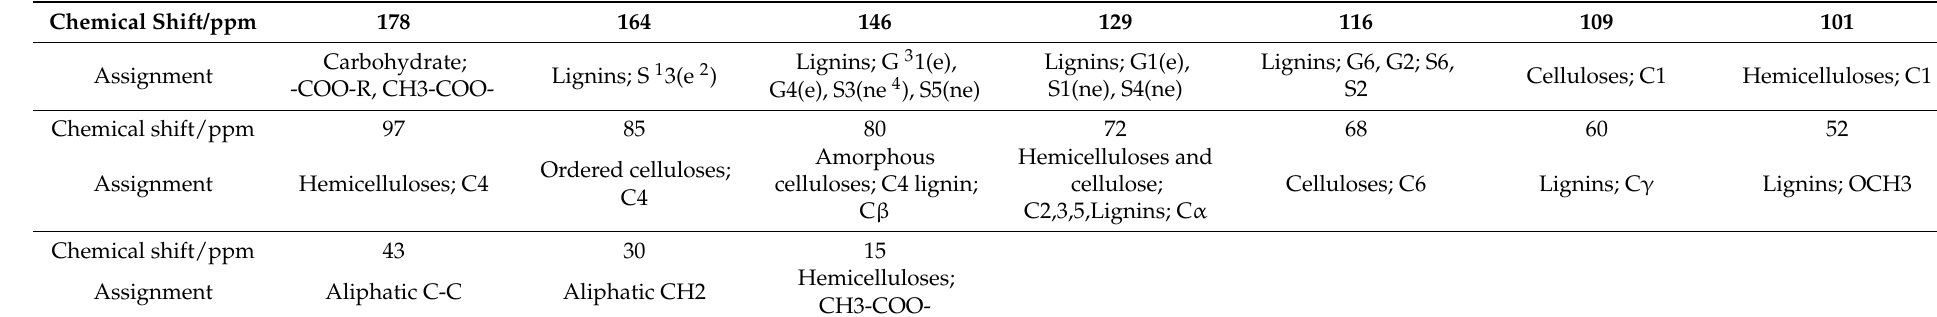
Table 1. Assignment of chemical